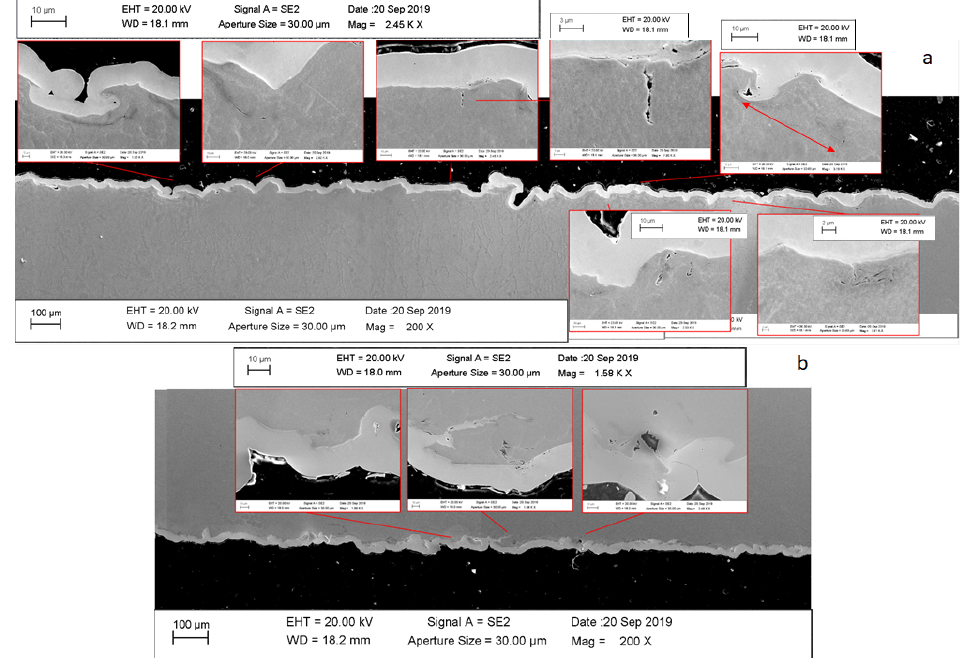
Figure 8. The SEM images from ( a ) the top and ( b ) the bottom side of the sample after peak load [27].